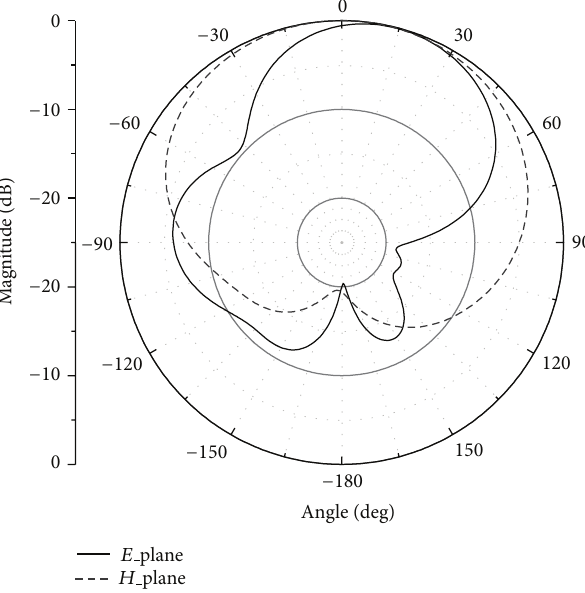
Figure 6: Measured far-field of the proposed PLPDA antenna at 35 GHz.